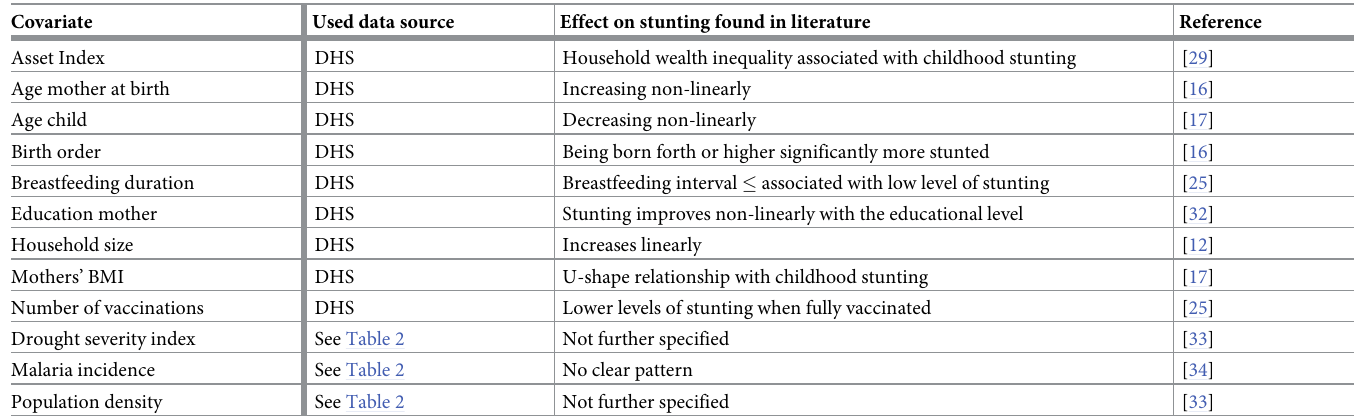
Table 1. Included covariates, their source, and effect on the height-for-age z-score found in the literature.